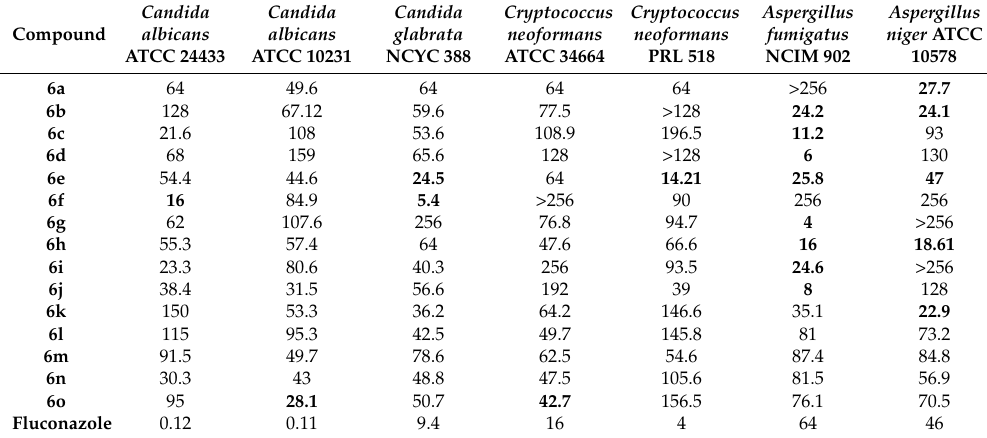
Table 2. Antifungal activity of the compounds 6a – o (IC 50 * in µ g/mL) against different human pathogenic